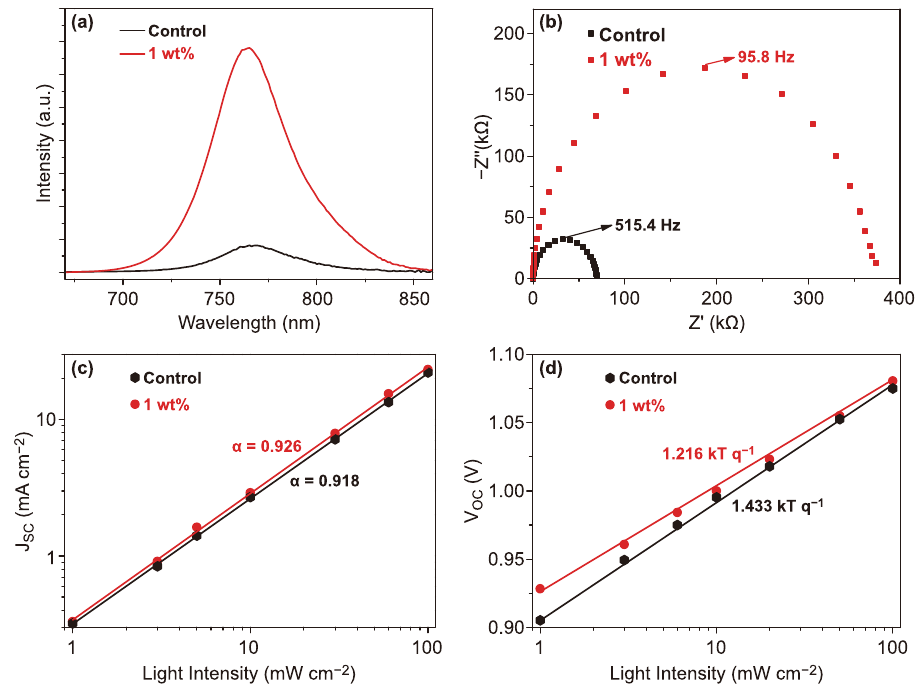
Fig. 5 a PL of the MAPbI 3 films with and without PEA on glass substrates. b EIS spectra, c J SC versus light intensity, and d V OC versus light intensity of